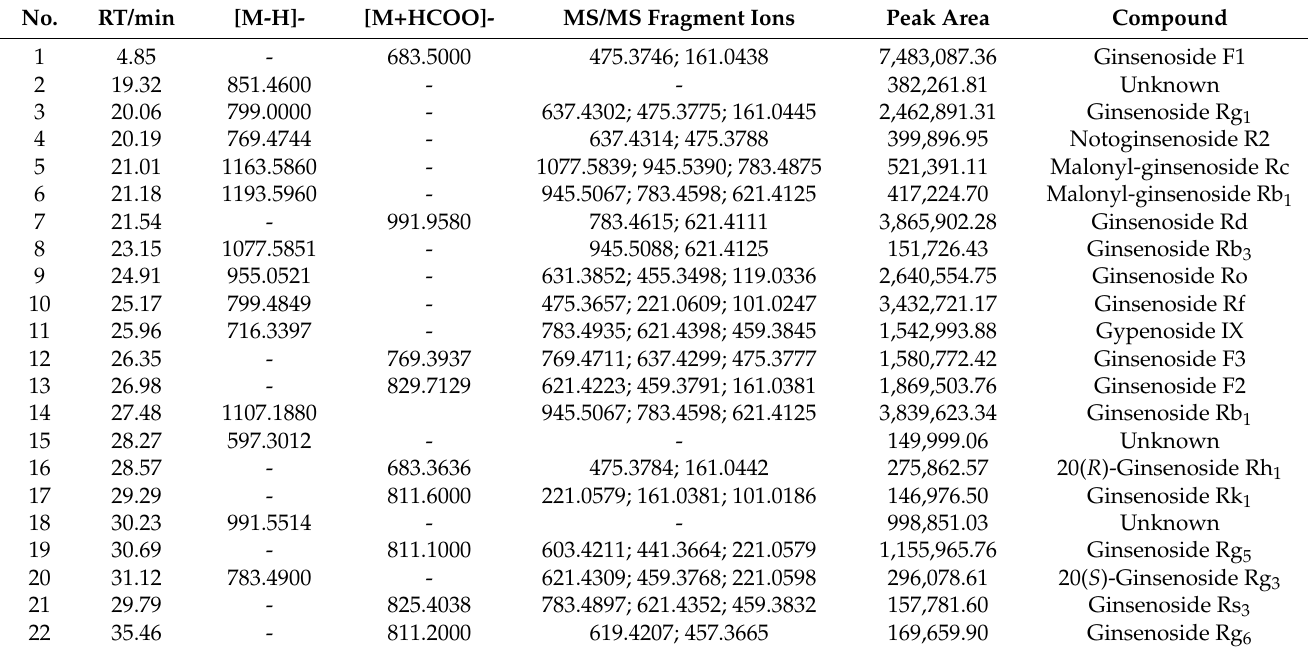
Table 1. Summary of compounds of phloem in ginseng identified by UPLC-Q-Exactive